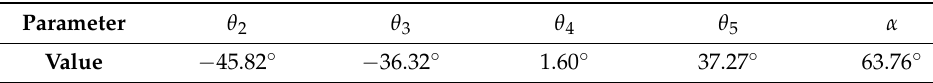
Table 4. Variables at the instant of pharyngeal jaw